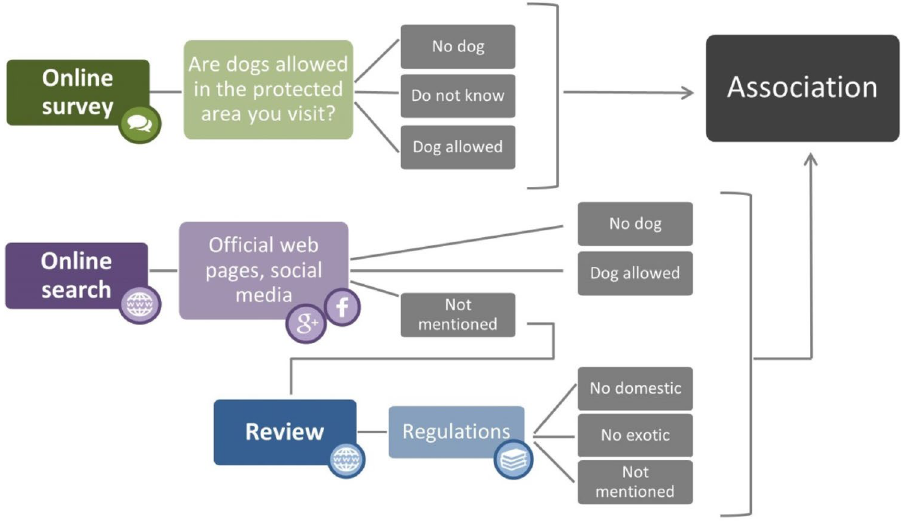
Figure 1. Steps followed to obtain data for the study of the association between the accessibility and clarity of regulations regarding dog access to protected areas in Argentina and people’s knowledge of these